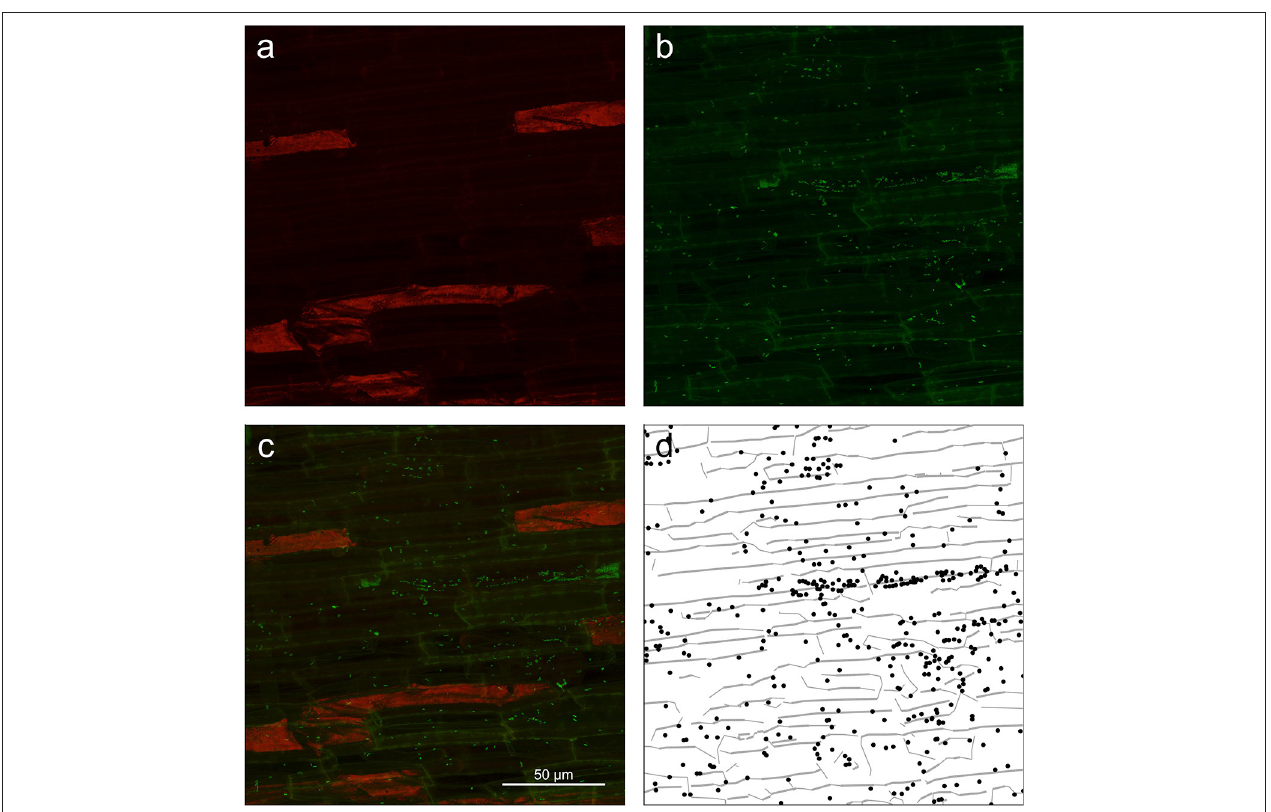
FIGURE 3 | Z-projection from the root mature region of (a) autofluorescence channel (shown in red) of the image showing only root cell walls, (b) dye channel (in green) showing both plant roots cell walls and microbial cells, (c) composite image of the surface of root showing root cell walls (yellowish lines) as well as microbial cells (green dots). (d) Extracted data from the image with root cell walls shown as gray lines and microbial cells as black